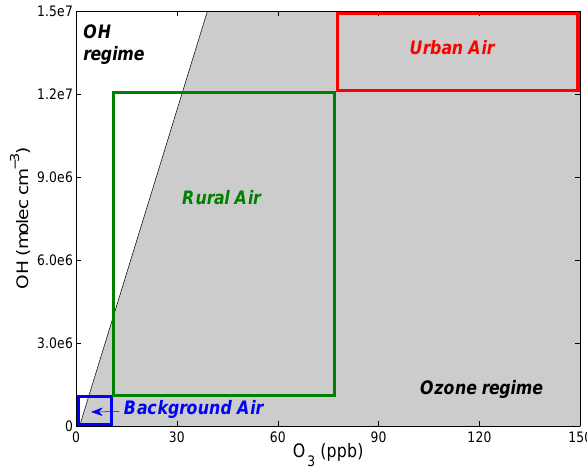
Fig. 12. Regimes of dominance of ozonolysis vs. OH oxidation of substituted dihydrofuran. Daily maximum OH concentrations vary by regions in the troposphere, i.e., 10 5 –10 6 moleculescm − 3 for background air, 10 6 –10 7 moleculescm − 3 for rural air, and >10 7 moleculescm − 3 for urban air, with a global average con- centration of 1 × 10 6 moleculescm − 3 . Daily average surface ozone mixing ratios in rural areas are between 10 and 50ppb, but these can exceed 100ppb in polluted urban